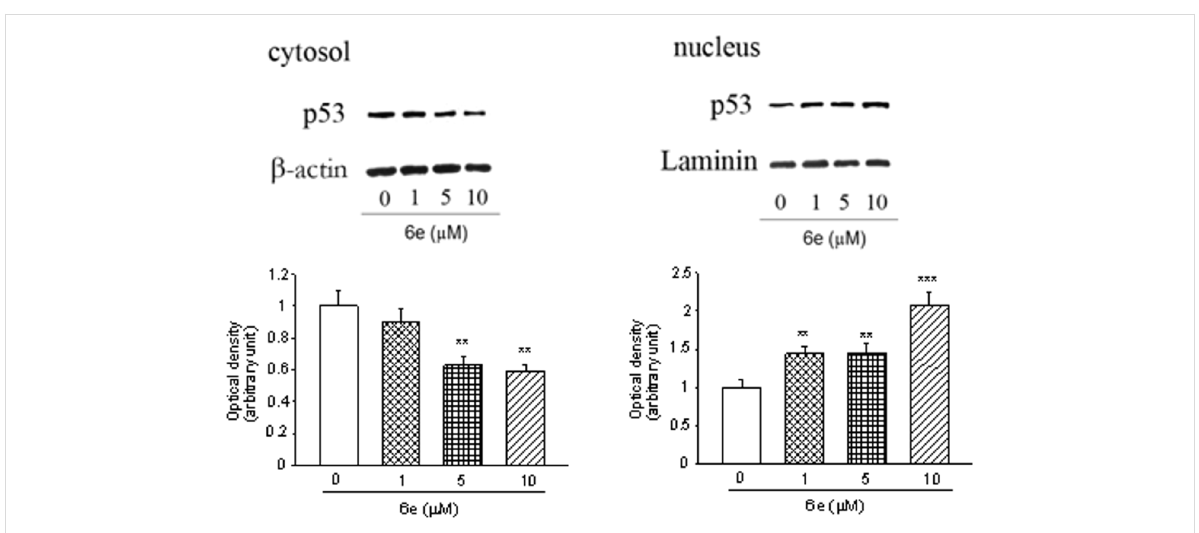
Figure 9: 6e modulate the levels of p53 in SH-SY5Y cells. (a) The SH-SY5Y cells were treated for 24 h with the indicated concentration of 6e , and then, both cytosolic and nuclear proteins were analyzed by Western blot for p53 protein. A representative immunoblot of three independent experi- ments is shown. (b) A densitometric analysis of autoradiographic bands collected from three separate experiments is shown. Levels of nuclear or cytosolic protein were normalized for laminin or β -actin, respectively. ** P < 0.01 and *** P < 0.001 vs untreated cells.